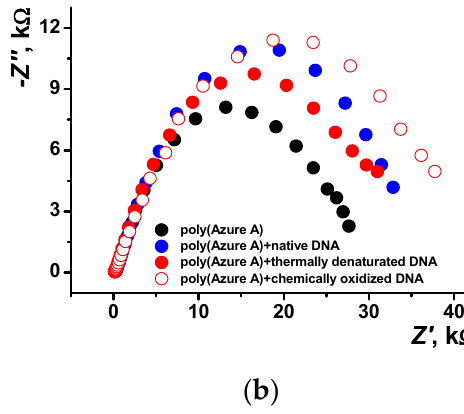
Figure 11. Nyquist diagrams of the impedance spectra recorded on the GCE covered with poly(Azure A) with and without DNA addition for the film–solution interface: ( a ) electropolymerization from aqueous solution of 0.2 mM Azure A in 0.1 M phosphate buffer containing 0.1 M NaNO 3 and 0.2 mg/mL DNA; ( b ) saturated with chloroform. Frequency range from 100 kHz to 0.04 Hz, amplitude of the applied sine potential 5 mV, pH = 7.0, and twenty cycles.